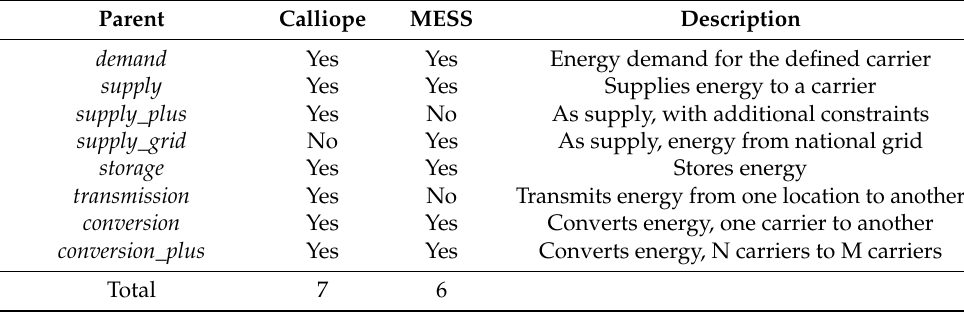
Table 2. Parent technology groups— Comparison between Calliope and